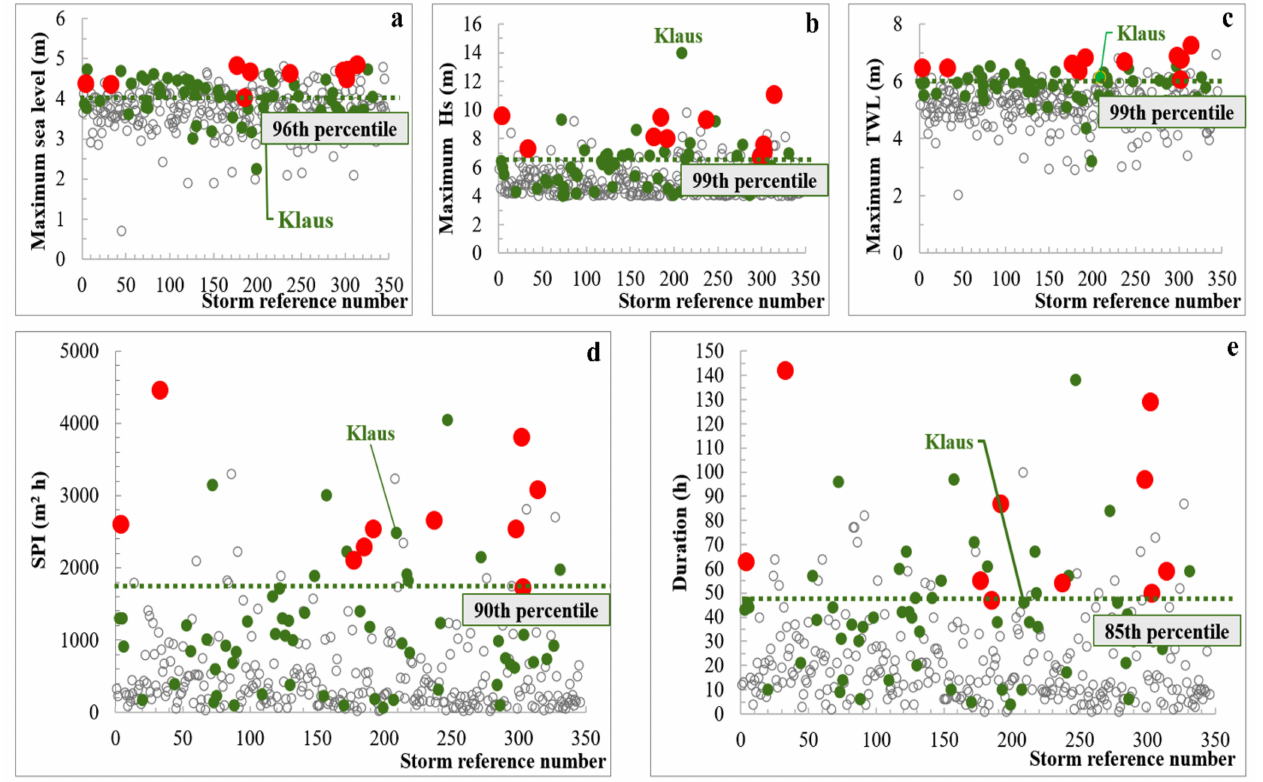
Figure 11. Thresholds of different hydrodynamic indicators corresponding to the top 10 damaging storms The lines show the empirical percentiles obtained for the 21-year storm database. No damage: hollow grey circles; Little/local damage: grey circles; High-impact storms: red circles. ( a ) Maxi- mum sea level; ( b ) Maximum wave height; ( c ) Maximum total water level; ( d ) Storm Power Index; ( e )